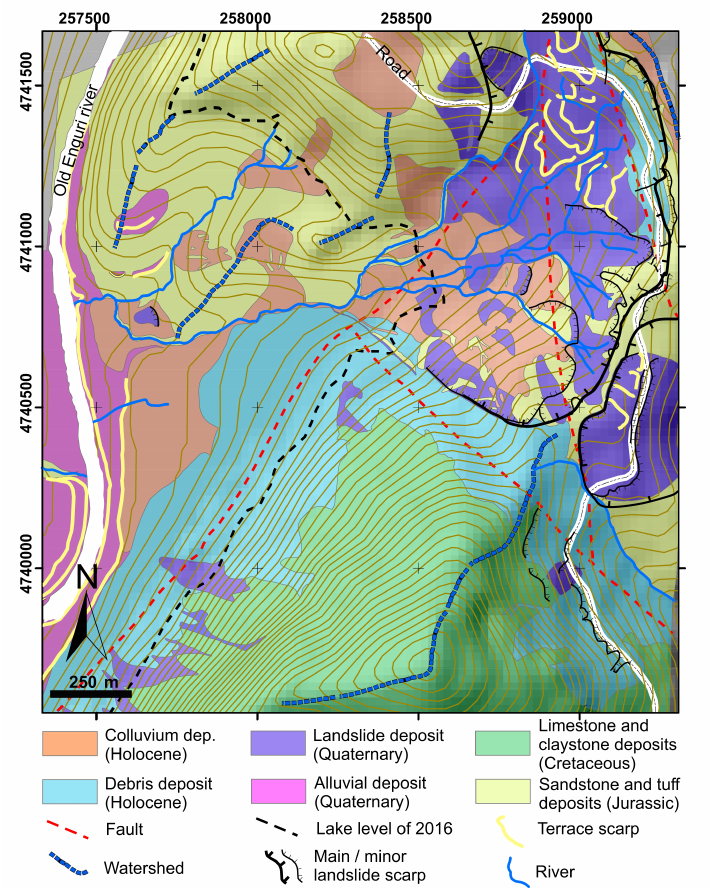
Figure 2. Geological and geomorphological map of the study area, modified after Tibaldi et al. (2019). Location in Fig.